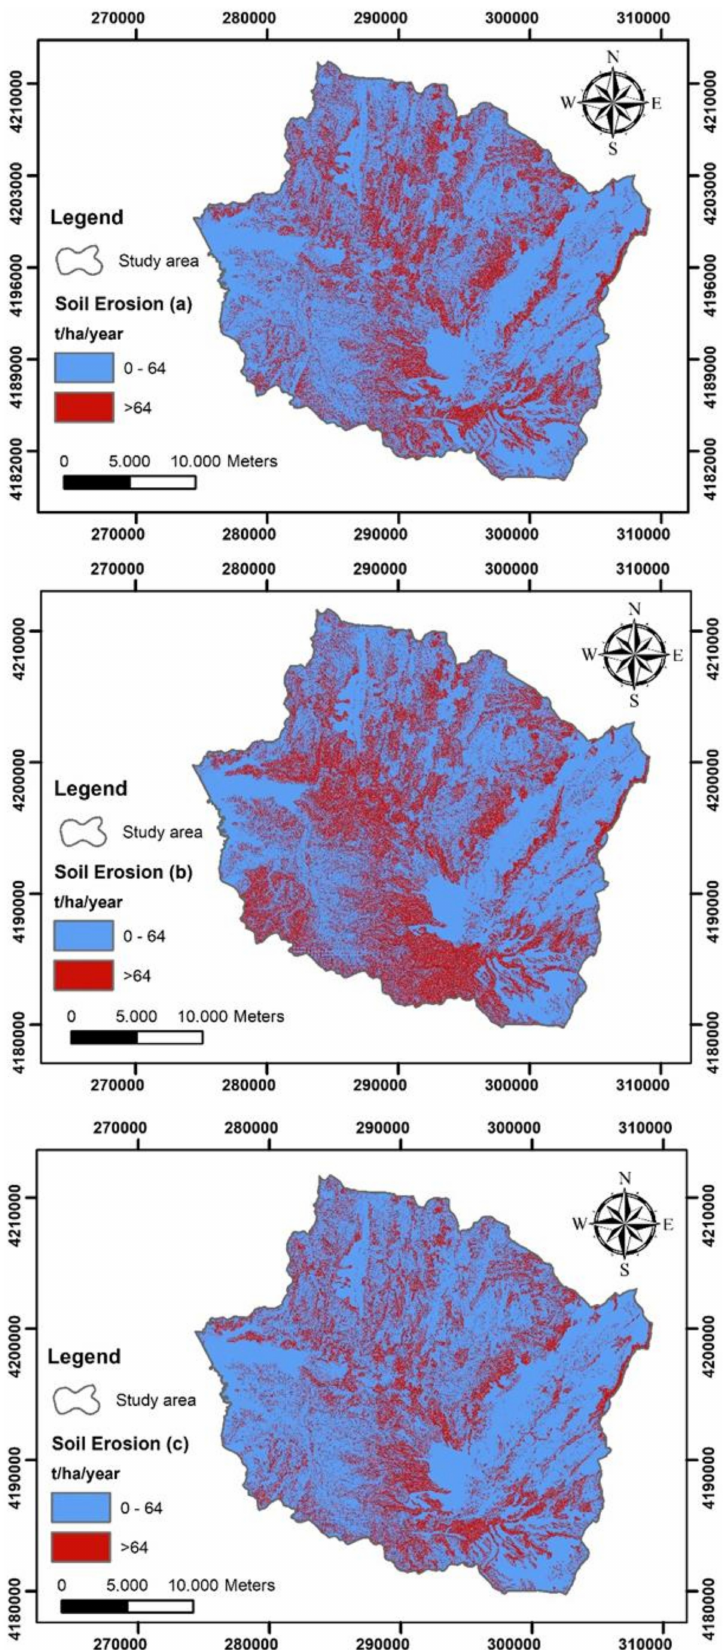
Figure 13. ( a ) Pre-fire soil erosion, ( b ) post-fire soil erosion, ( c ) existing soil erosion—maps of the research